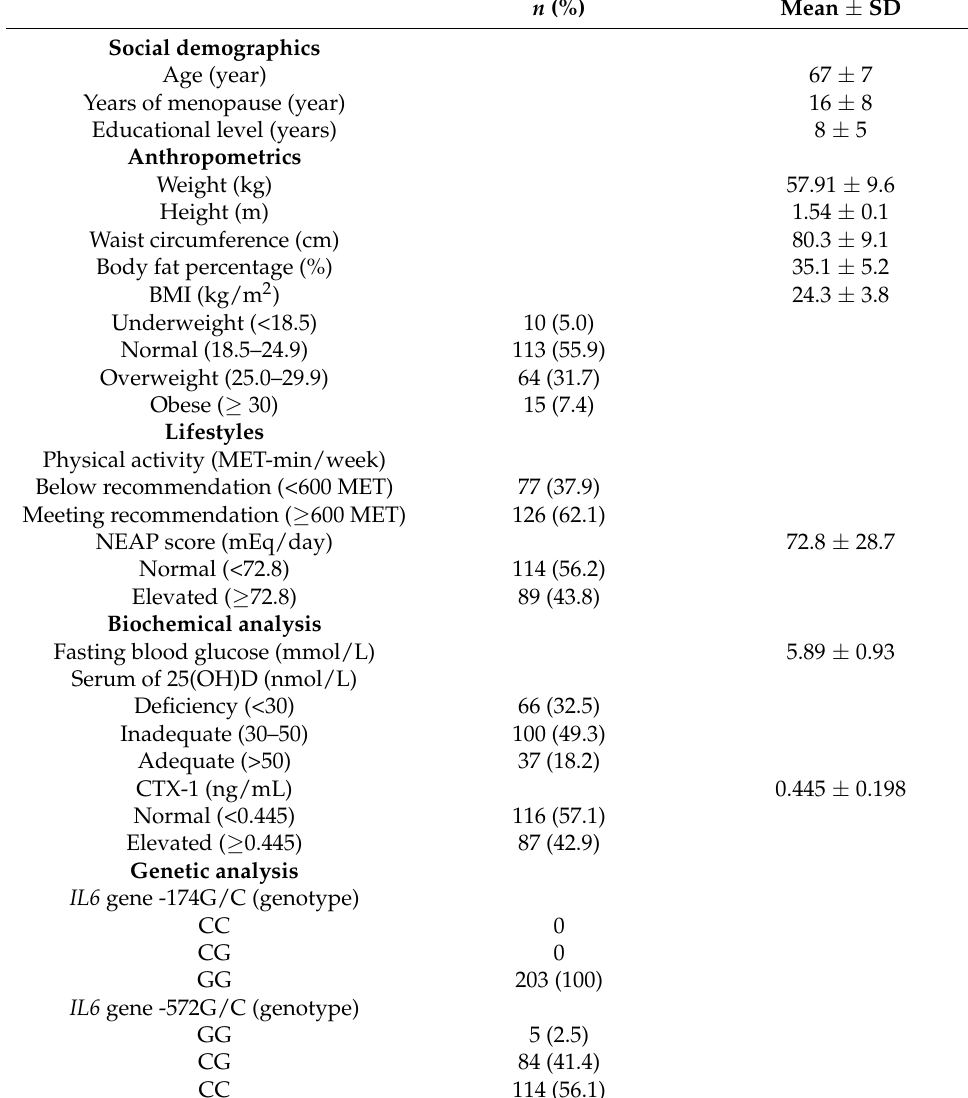
Table 1. Characteristics of the study